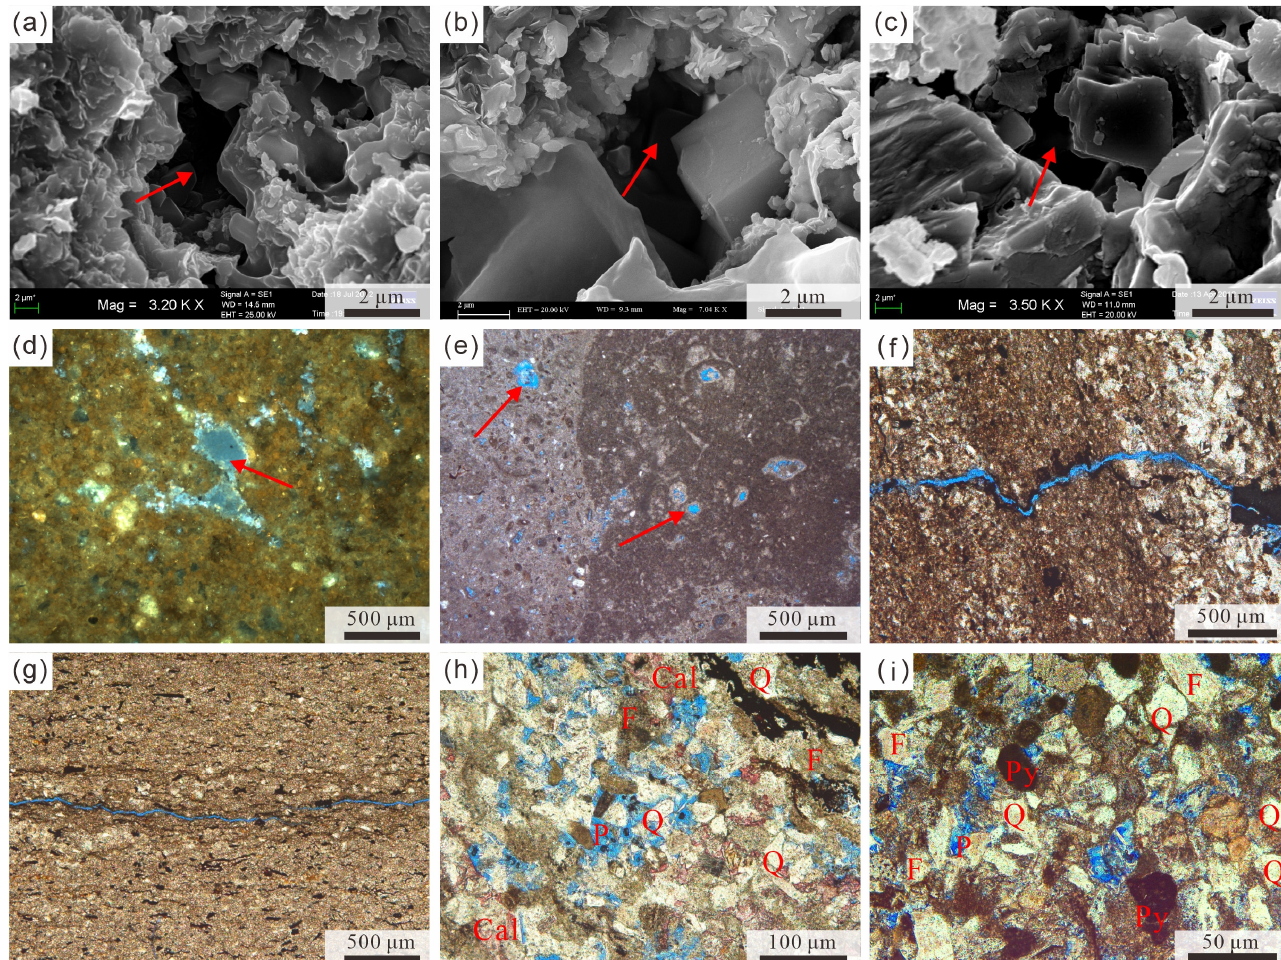
Figure 7. Reservoir space types of the Permian Lucaogou Formation in the Jimsar Sag. ( a ) Gray argillaceous siltstone, development of dissolution pores in the matrix, J174, 3334.68 m, SEM; ( b ) gray, argillaceous, silty sandstone, dissolution of potassium feldspar grains and dissolution pores in the matrix, J174, 3333.76 m, SEM; ( c ) gray marl rock, intragranular dissolution pores and intergranular pores, J174, 3182.43 m, SEM; ( d ) gray calcareous siltstone, dolomite intercrystalline pores, J174 3144.84 m, fluorescence thin section; ( e ) gray marl, calcite intercrystalline pores, J174, 3112.09 m, PPL; ( f ) gray dolomitic siltstone, developmental microcracks, J251, 3777.44 m, PPL; ( g ) gray marl, developmental microcracks, J31, 2712.85 m, PPL; ( h ) gray, fine, calcareous sandstone, residual intergranular pores containing calcite cement, J31, 2725.16 m, PPL; ( i ) gray calcareous siltstone, residual intergranular pores containing pyrite, J174, 3142.13 m, PPL. Cal: calcite; Q: quartz; F: feldspar; Py: pyrite; P: pores; PPL: plane-polarized light. Red arrows indicate dissolution pores, intergranular pores.